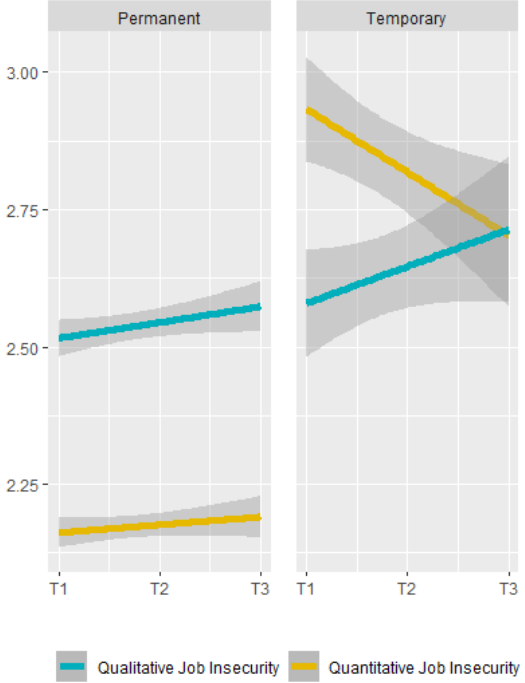
Figure A1. Employment contract.